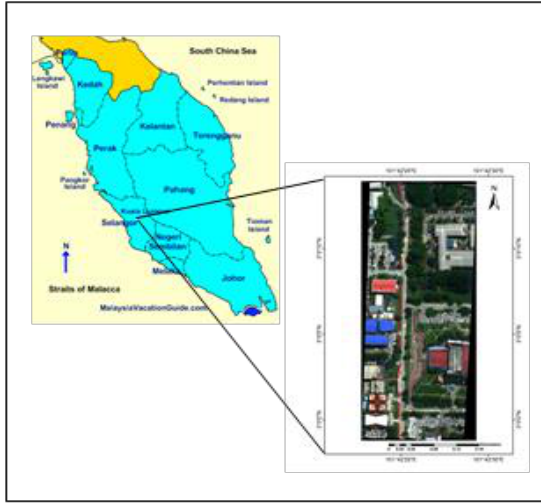
Figure 1: Study area and acquired data.